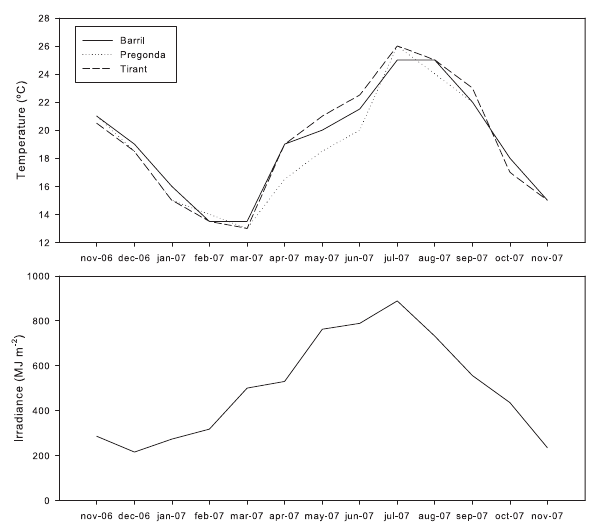
Fig . 2. – Seasonal variation of environmental parameters. Upper panel: temperature values measured monthly in situ at the three study sites during the entire study period. Lower panel: Irradiance values from the study area and for the whole study period obtained from AEMET (Spanish Meteorological Agency).